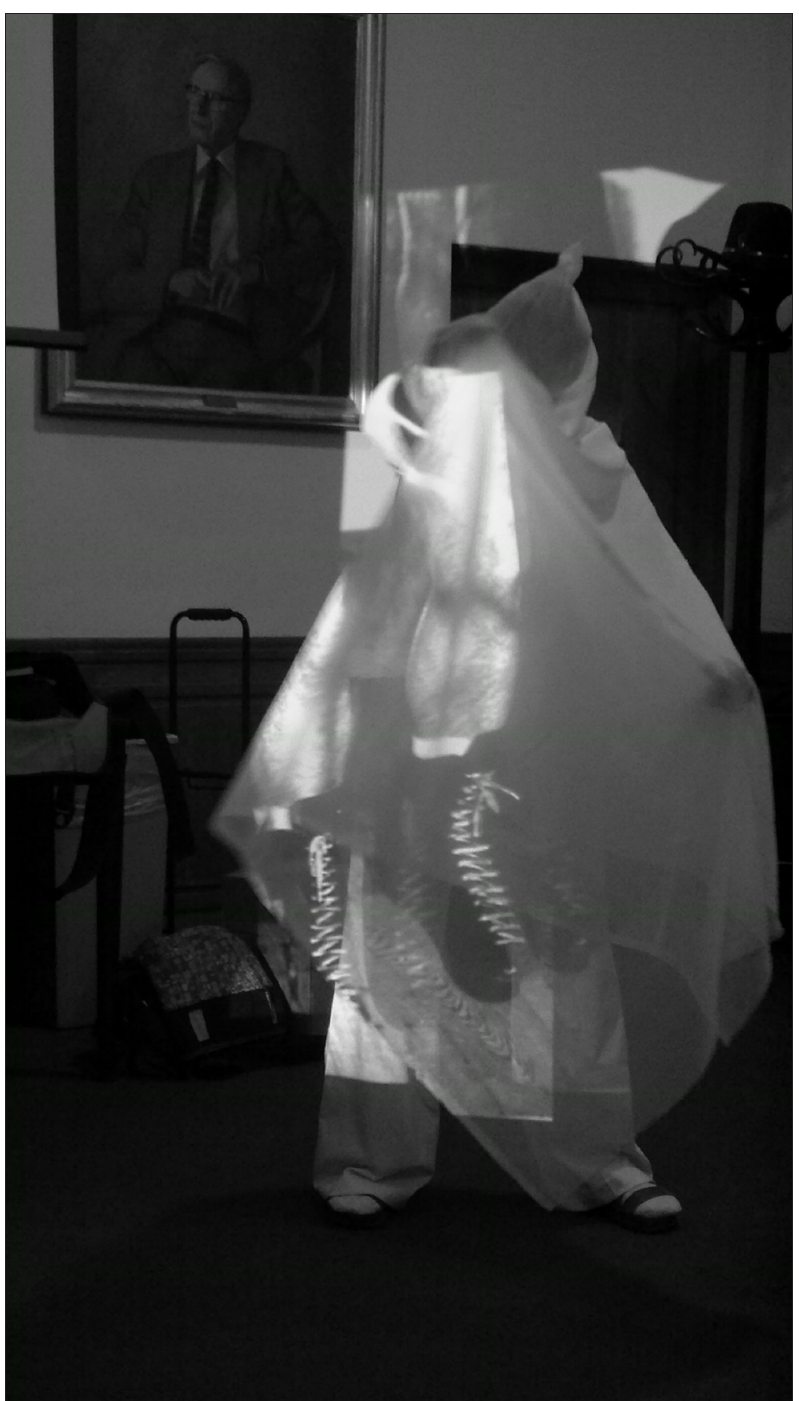
Figure 3.1: Jennifer Pike at Birkbeck College, University of London, 2011. Courtesy of